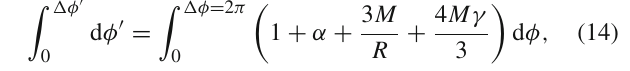
which is a result of the existence of a time-like Killing vec- tor associated with the spacetime. Here, ( r i , ν i ) and ( r , ν) are, respectively, the initial and the observed values of the radial distance to the source and frequency. For the near-earth experiments,however,wehave α (cid:9) 1and γ r (cid:9) 2 M / r